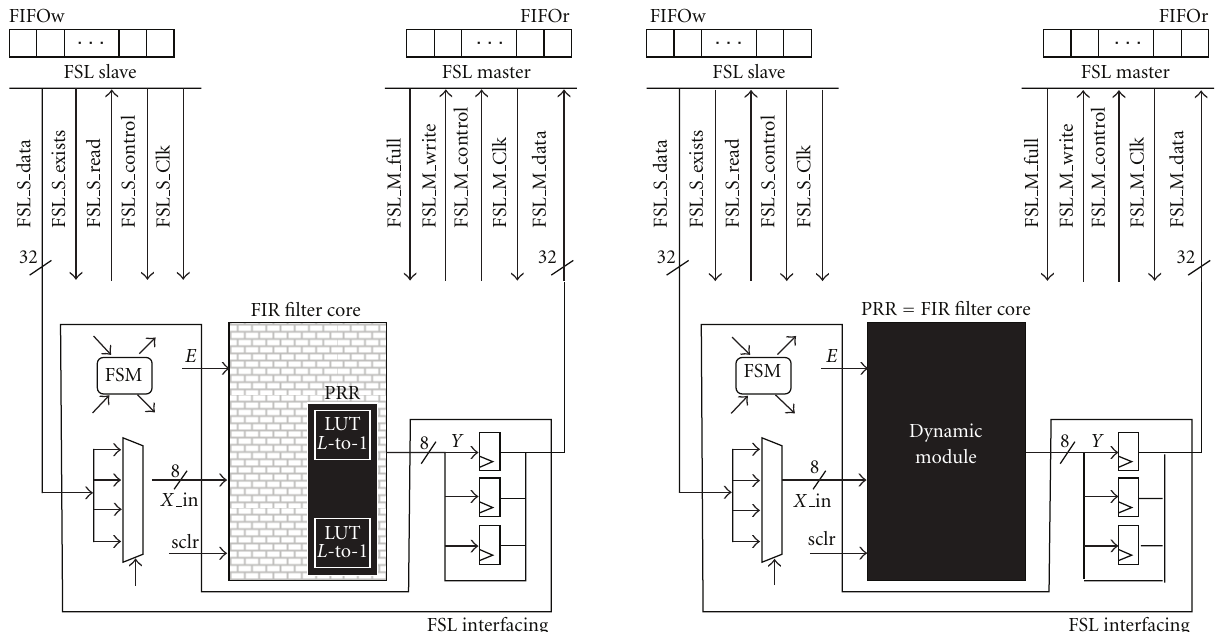
Figure 8: Dynamic FIR filter processor interfacing with FSL. PRR for dynamic reconfiguration of the coe ffi cients (left) and PRR for dynamic reconfiguration of the number of coe ffi cients, their values, and symmetry (right). DDRRAM. When needed, they are written to the ICAP